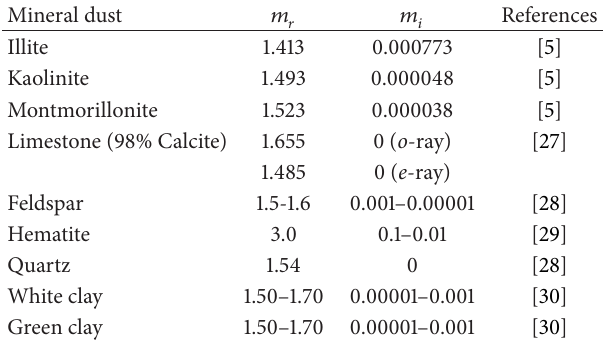
Table 2: Complex refractive indices of minerals derived from some